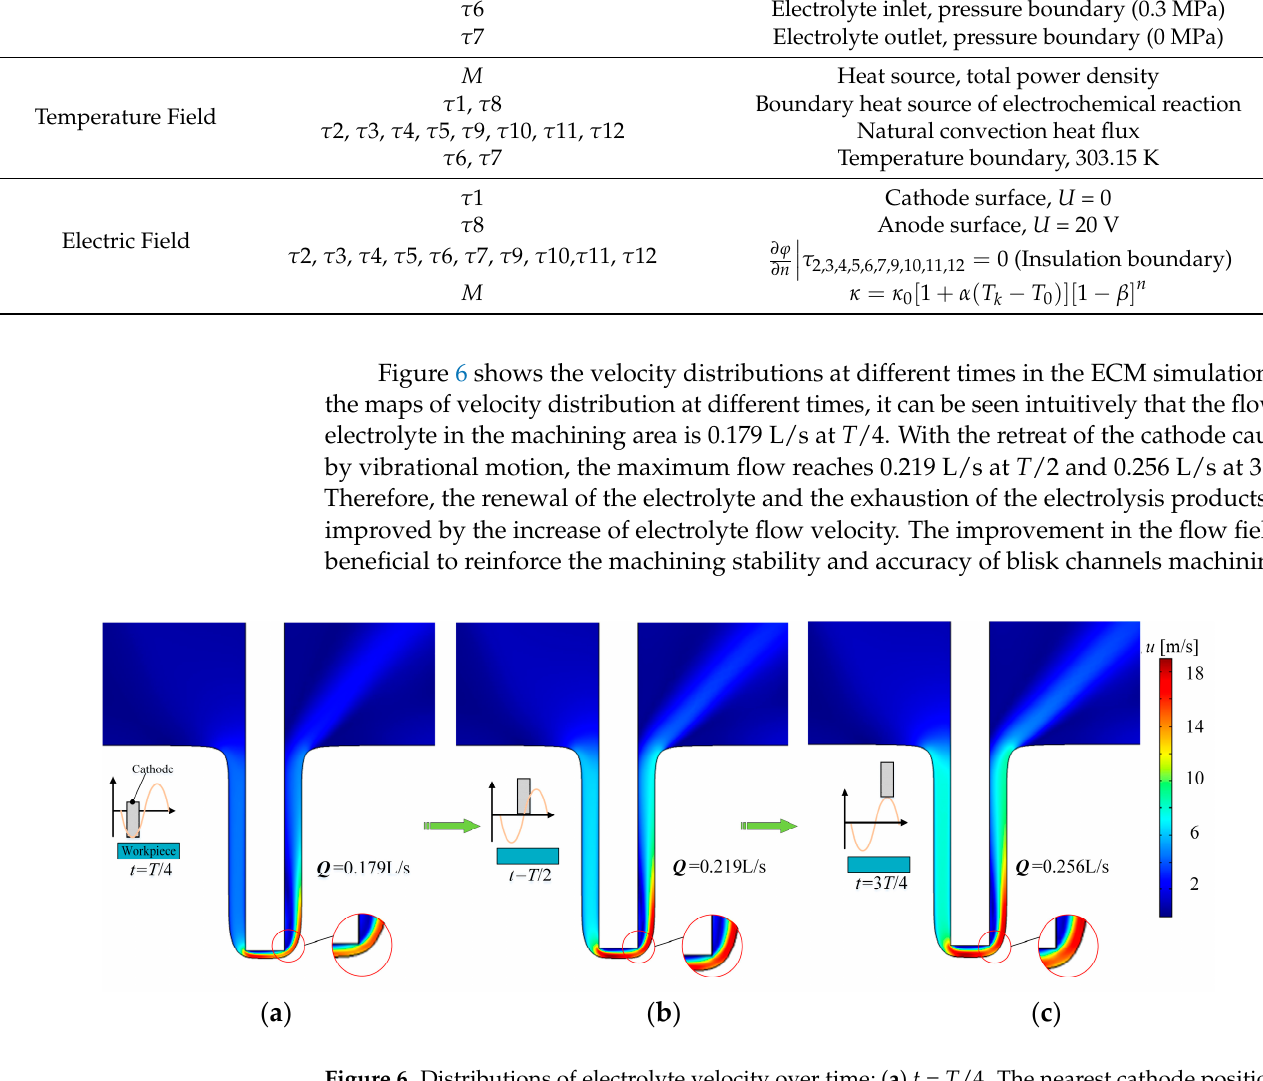
Figure 5. Boundary distribution in simulation.